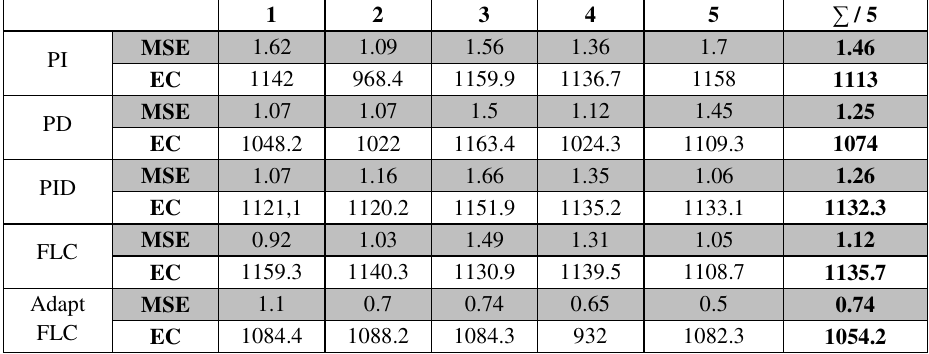
Table 2 ( A ). The MSE obtained during each simulation Set points 1